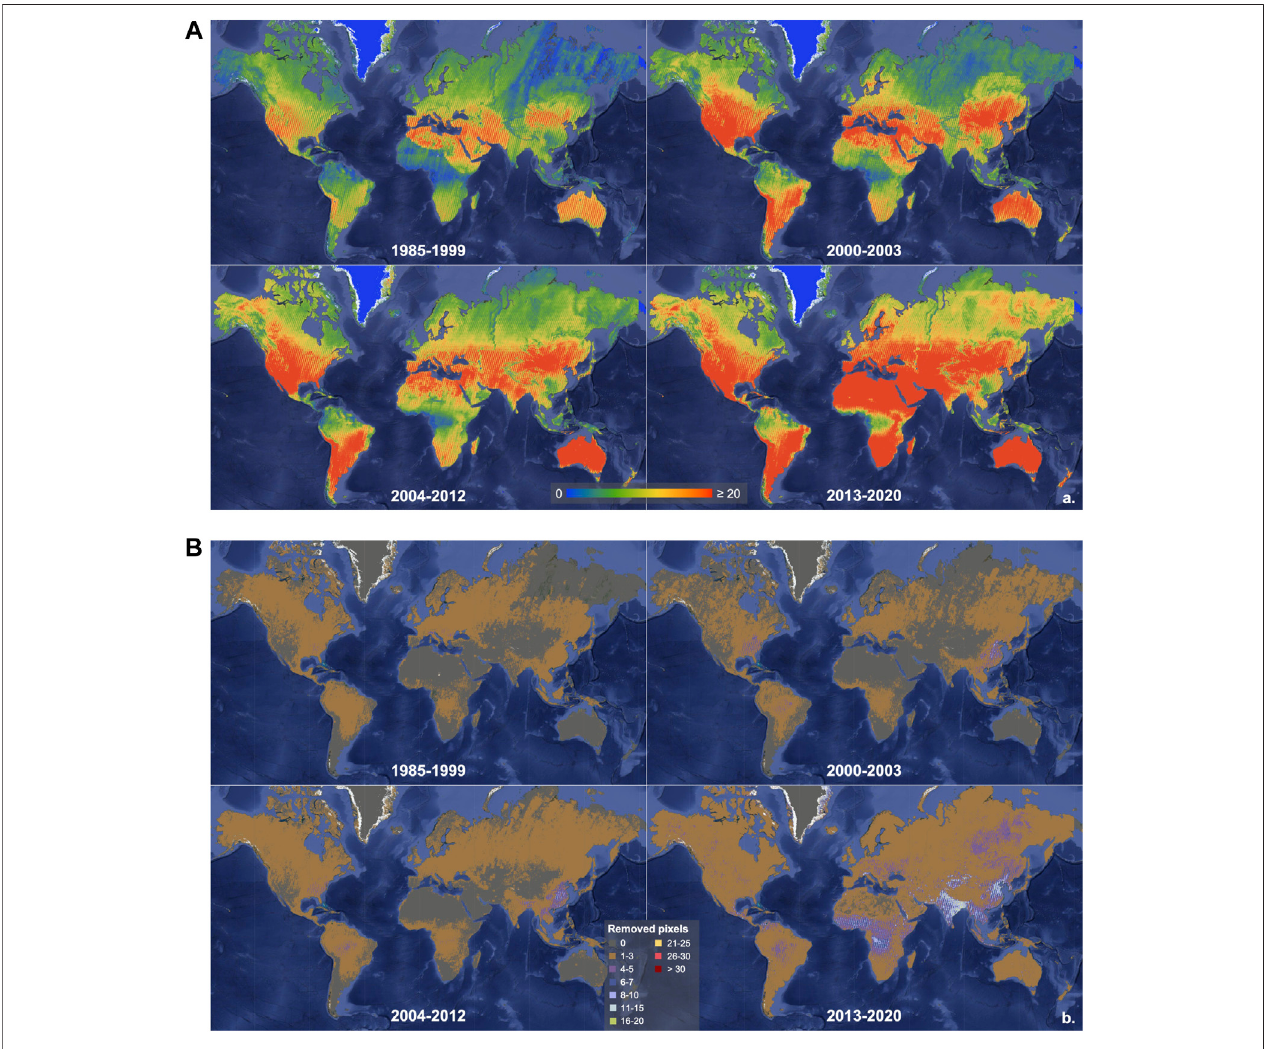
FIGURE 4 | (A) Average number of annual observations after fi ltering cloud, cloud shadow, snow, saturated, unrealistic SR, and hazy atmospheric pixels. (B) Average number of observations removed per year by fi ltering pixels with a hazy atmosphere. The difference is between maps in Figures 3A , 4A .